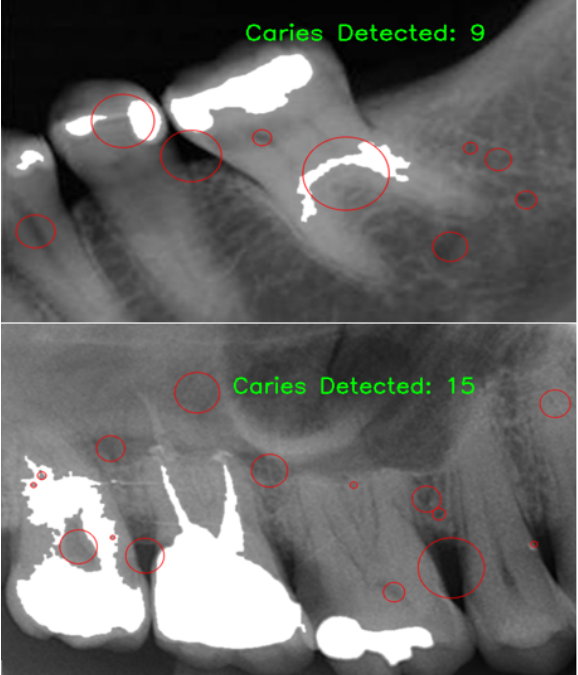
Figure 4. Gaussian filtered images of all caries detected regions, including false positives.